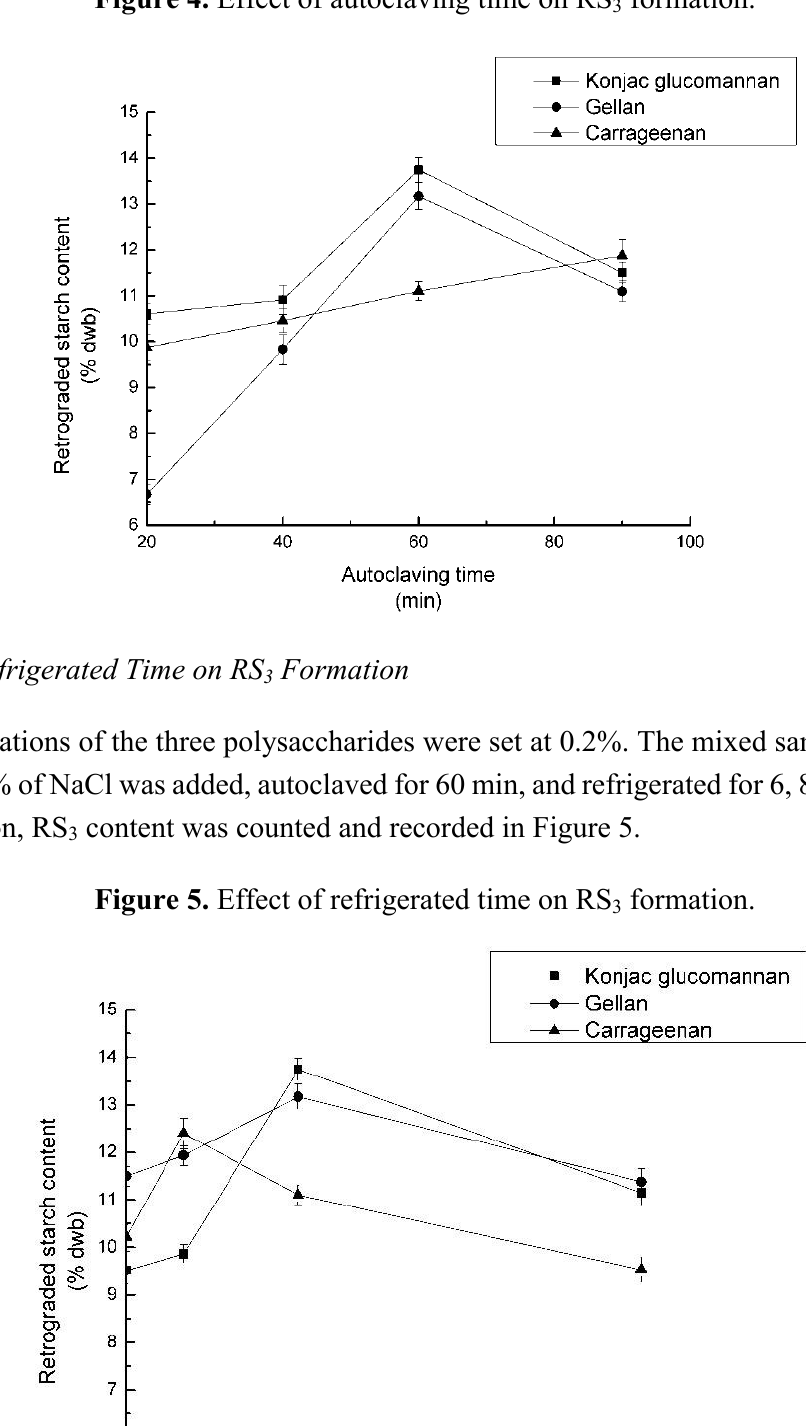
Figure 4. Effect of autoclaving time on RS